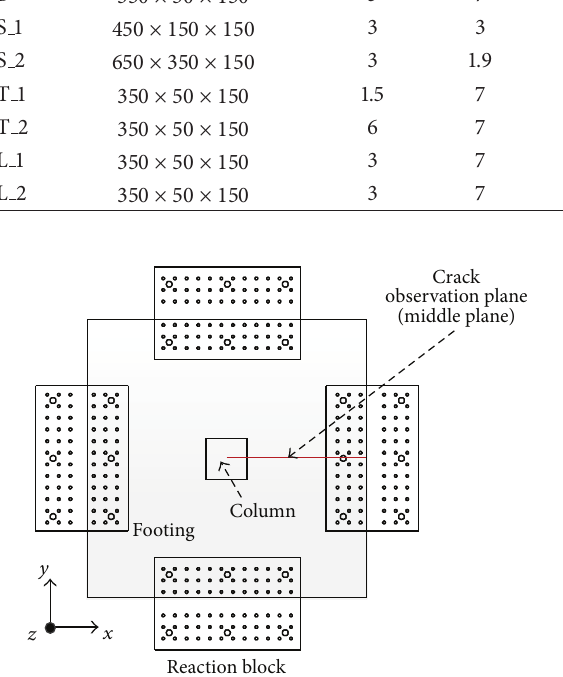
Figure 14: Location of crack observation plane for test